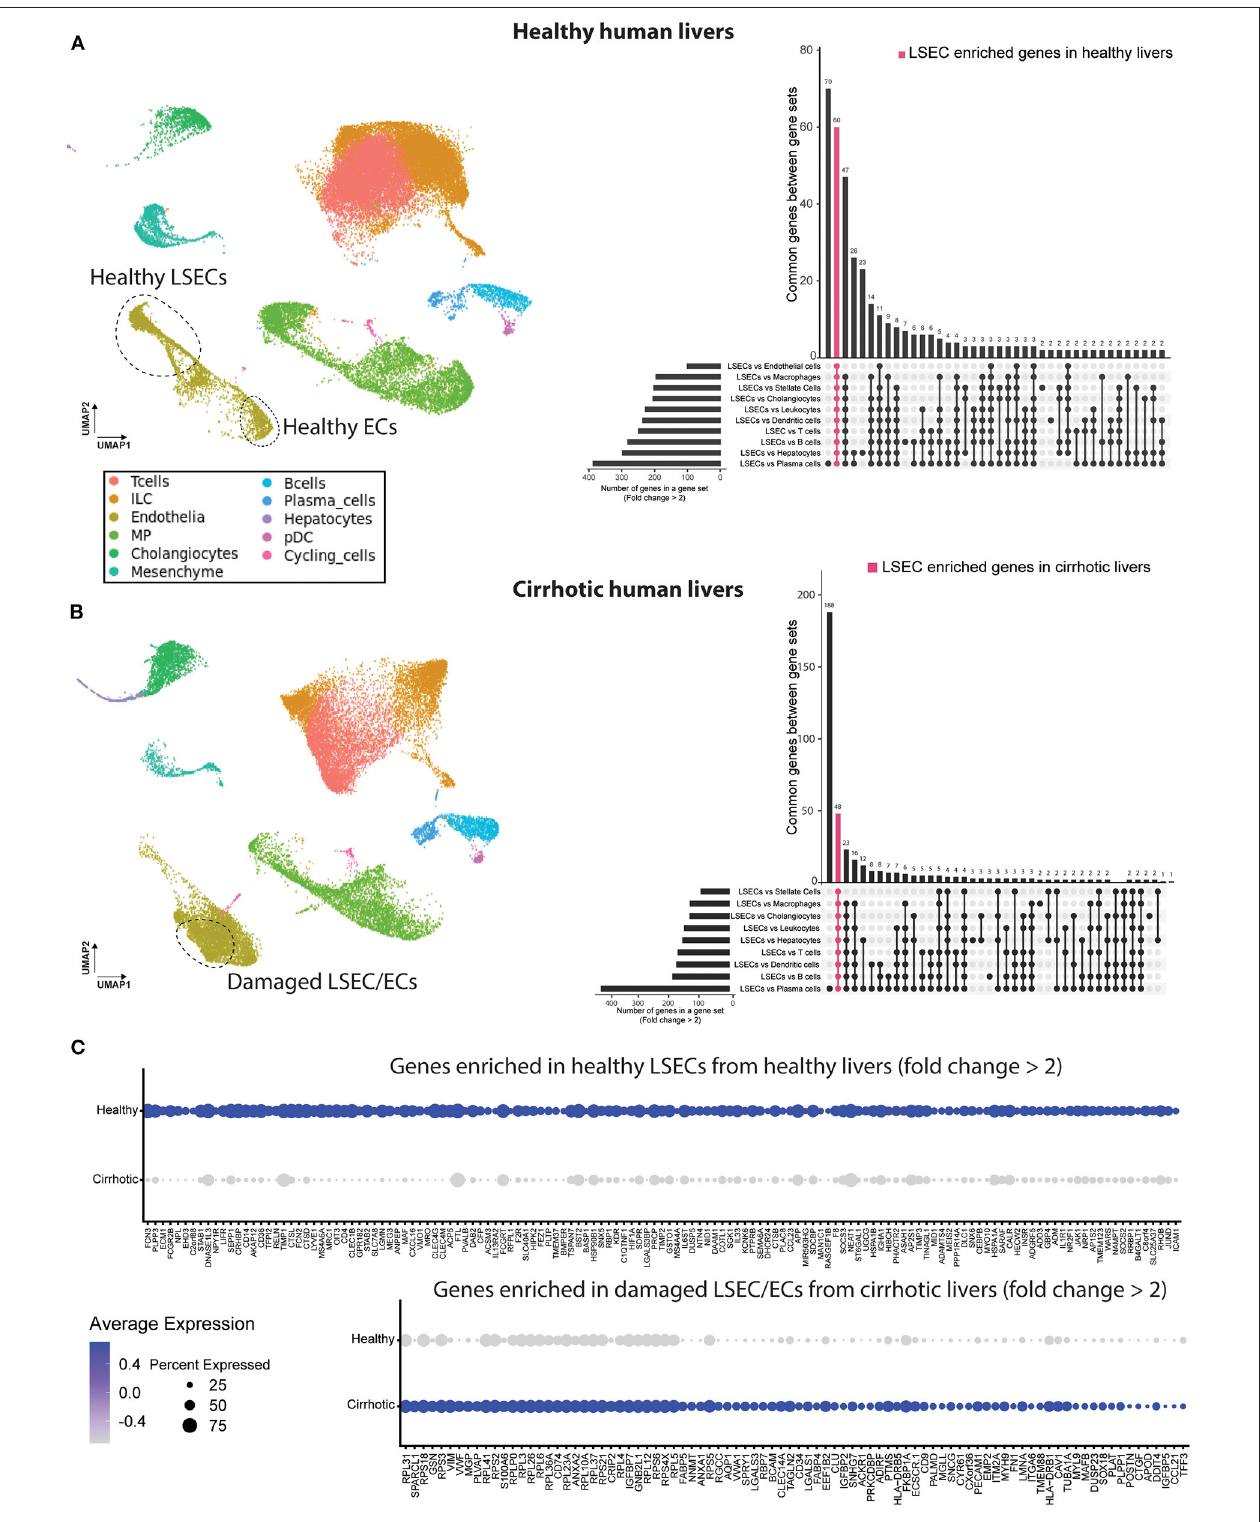
FIGURE 1 | Identification of genes higher expressed in LSECs in healthy and cirrhotic human livers. Left a UMAP plot of scRNAseq data of healthy (A) and cirrhotic (B) liver cells (25). Right an upset plot of differentially expressed genes (fold change > 2) in LSECs or damaged LSEC/ECs compared to all other cell types. Pink color represents LSEC enriched genes in healthy livers (60 genes) or damaged LSEC/EC enriched genes in cirrhotic livers (48 genes). (C) Dotplot of differentially expressed genes between LSECs of healthy and cirrhotic livers with fold change > 2. All results were obtained with the use of the dataset of Ramachandran et al. (25).